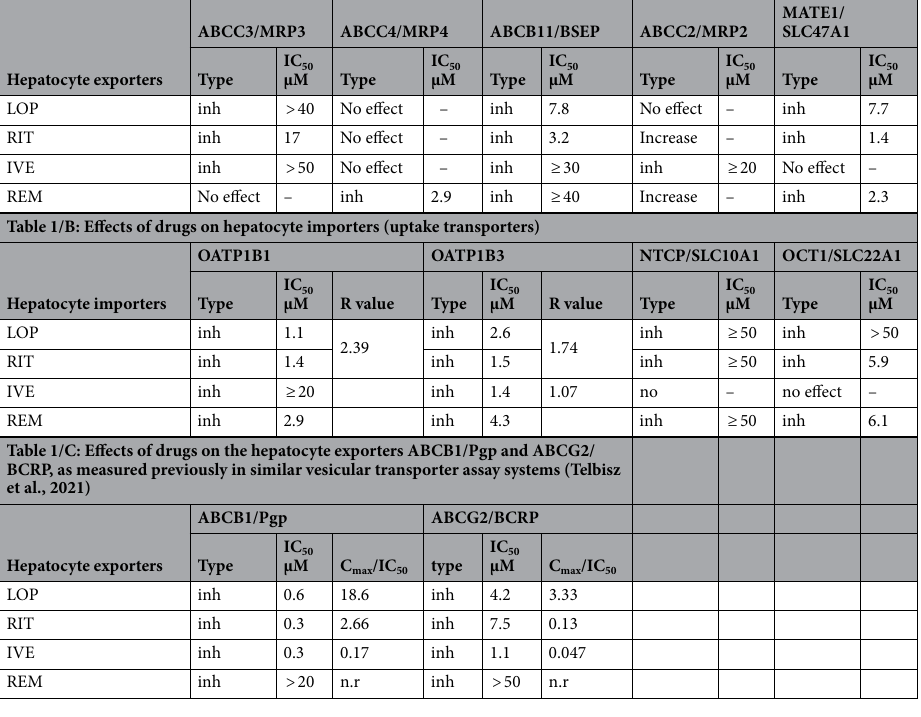
Table 1. Summary of the transporter modulation properties of the repurposed anti-COVID-19 drugs examined in transport assays. Approximate IC 50 (μM) values were determined by nonlinear regression analysis of the data shown in the results section, using GraphPad prism software (version 5.01, GraphPad, La Jolla, CA, USA). Favipiravir (not listed) had no effect on any of the transporters examined. Estimation of the DDI effects was performed as described in the Methods section, and references for in vivo parameters were provided in the Discussion. For importers the R values (cut off value 1.1), while for the exporters C max /IC 50 values (cut off value 0.1) were calculated. For lopinavir and ritonavir R values were calculated for a combined treatment.